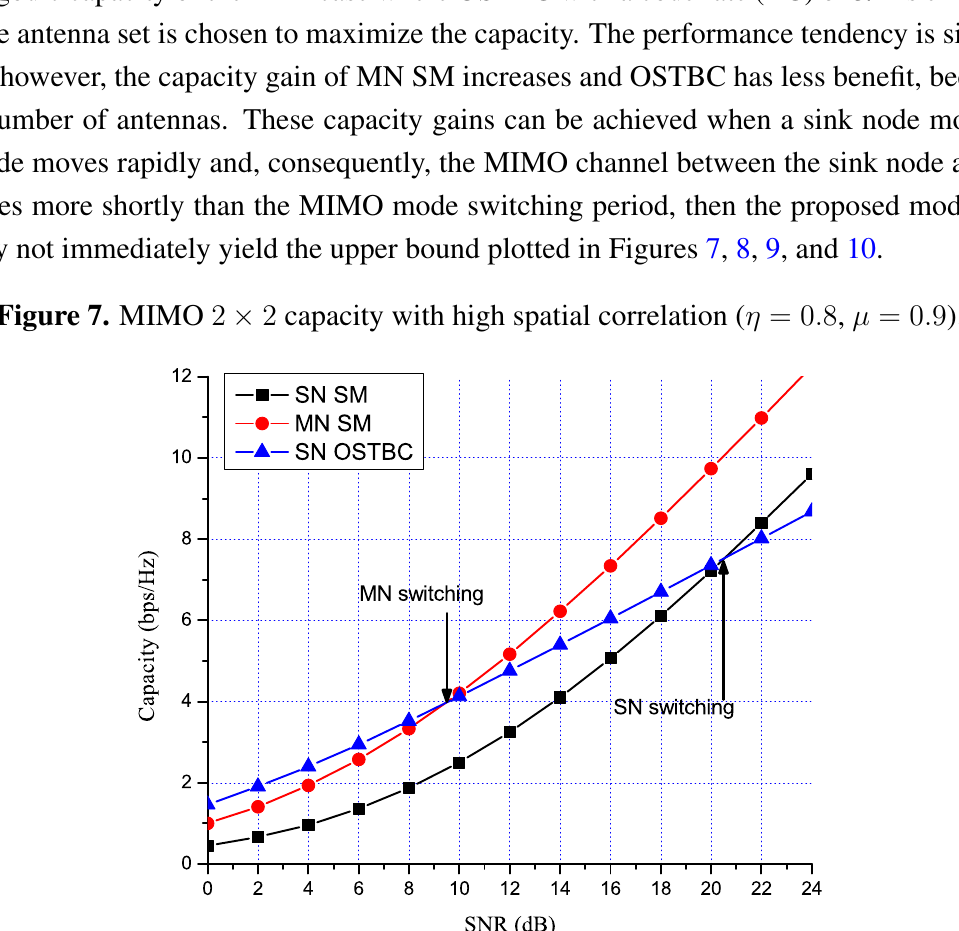
Figure 8. MIMO 2 × 2 capacity with low spatial correlation ( η = 0 . 3 , µ = 0 . 9